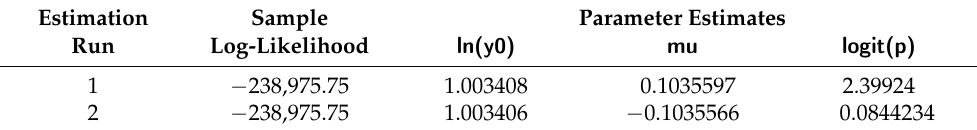
Table 1. Maximum likelihood estimates of parameters of a mixed susceptibility Wiener model computed from two estimation runs. Estimates are based on a single simulated right-censored sample of 100,000 individuals but from estimation runs with different starting values for the numerical optimization routine. The true parameter values are ln ( y 0 ) = 1, µ = − δ ∗ = 0.1 and logit p ∗ = ln [ 0.9/ ( 1 − 0.9 )] = 2.1972. Estimation Sample Parameter